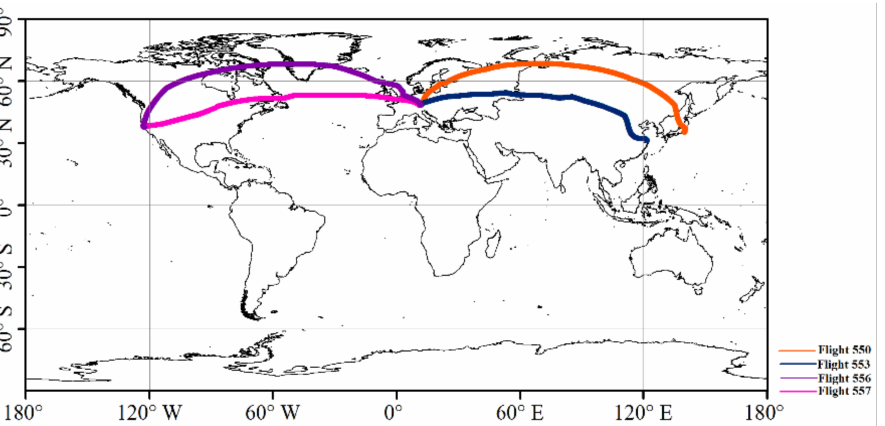
Figure 1. Civil Aircraft for the Regular Investigation of the Atmosphere Based on an Instrument Container (CARIBIC) data for four flights. Orange line is flight 550 (29 July 2018), blue line is flight 553 (31 July 2018), purple line is flight 556 (10 October 2018), pink line is flight 557 (11 October